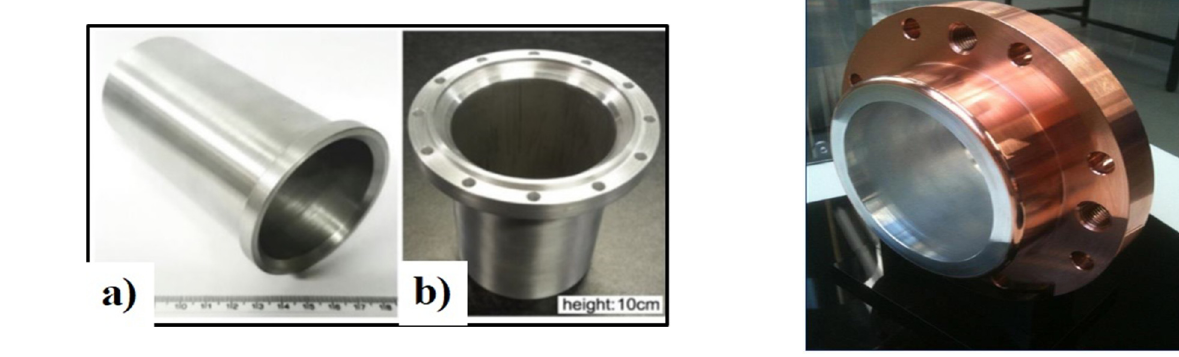
Figure 5: CSAM pipe after machining: ( a ) Al alloy cylindrical pipe and ( b ) Al alloy fl ange. Figure 6: Photographic view of CSAM copper fl ange [ 48 ]